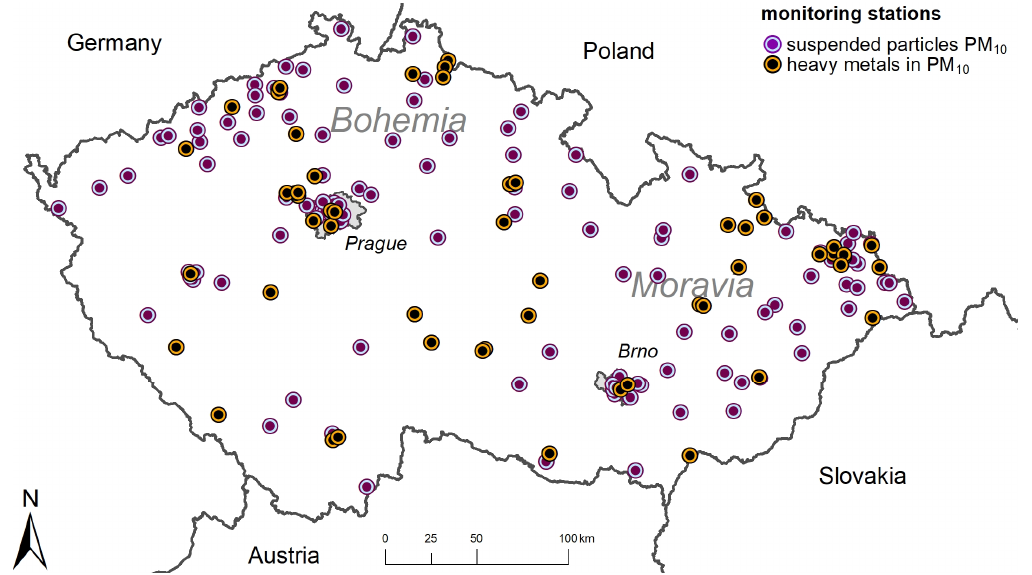
Figure 2. Map showing stations for monitoring heavy metals in PM 10 used for creating dry deposition maps, situation in 2019.